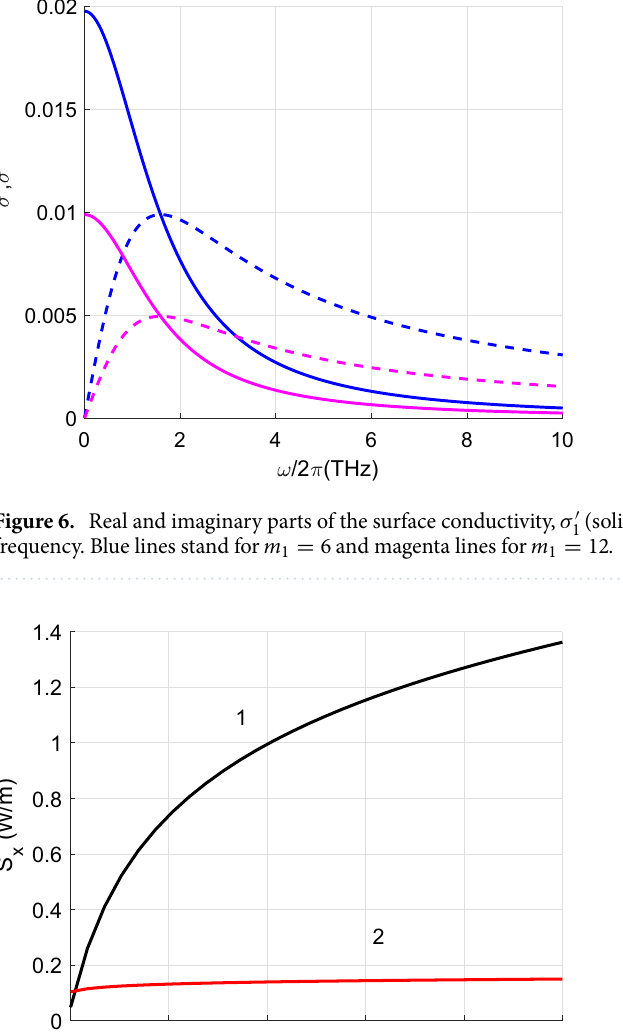
τ 2 , for metallic =